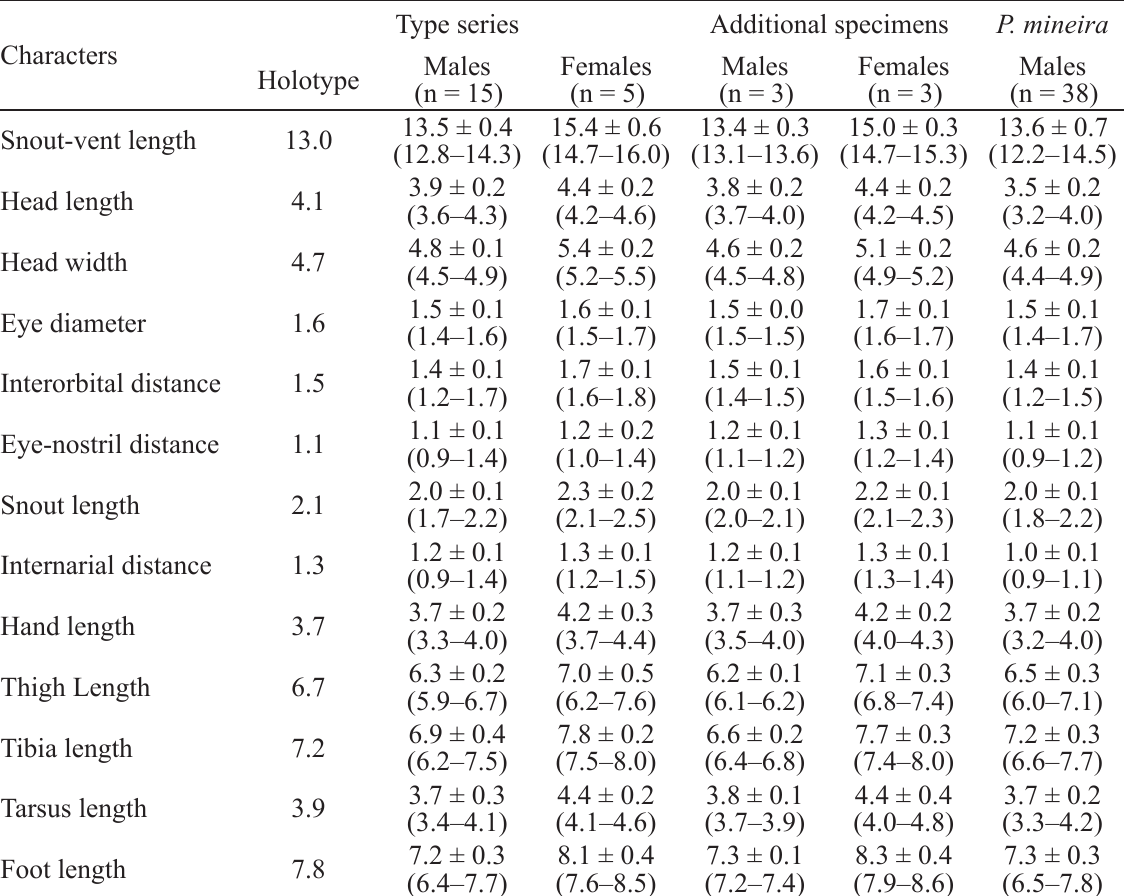
Table 1. Morphometry of the type series and additional specimens of Pseudopaludicola matuta sp. nov., and of specimens of P. mineira Lobo, 1994 (including types and additional specimens designated by Lobo 1994). Values presented in millimeters as mean ± standard deviation (minimum–maximum); n = number of measured